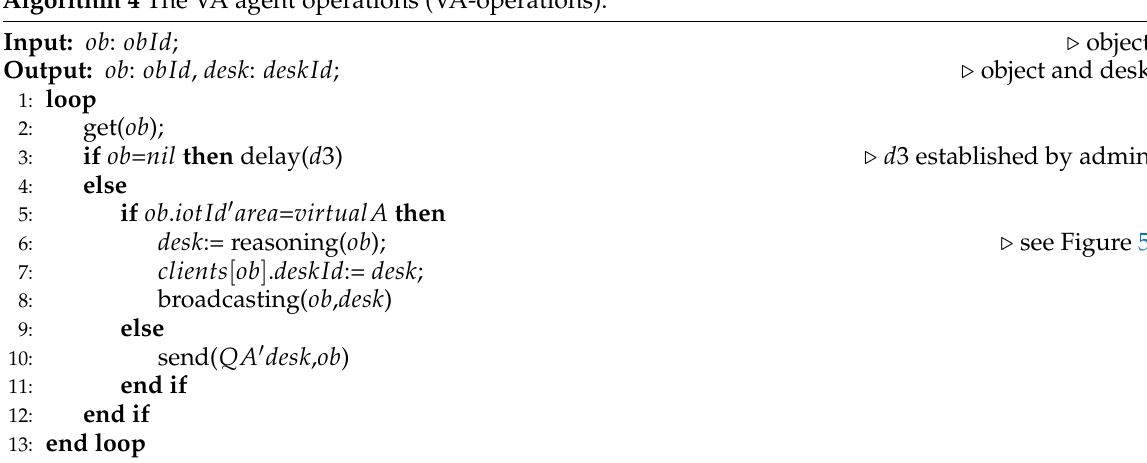
Algorithm 4 The VA agent operations